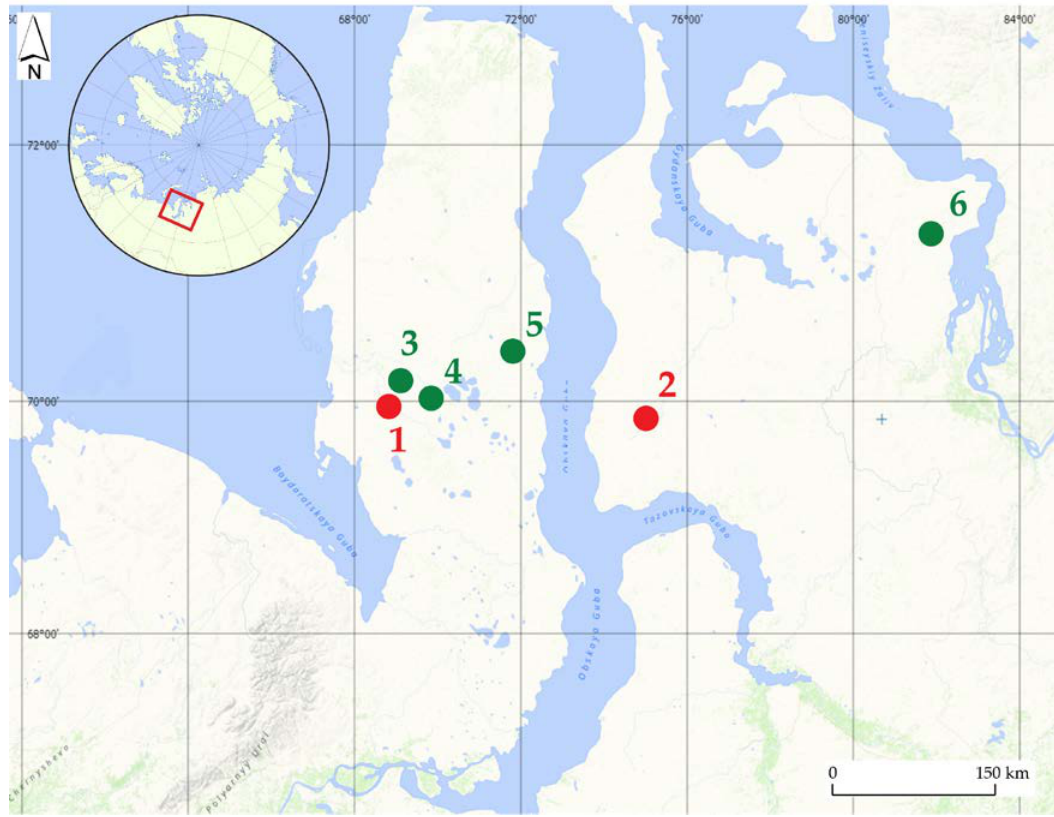
Figure 1. Scheme of the gas-emission craters location. Craters under study: 1, GEC-1 on Central Yamal; 2, AntGEC on Gydan Peninsula. Other known craters in the North of West Siberia: 3–5, on Yamal Peninsula; 6, on Yenisei Bay